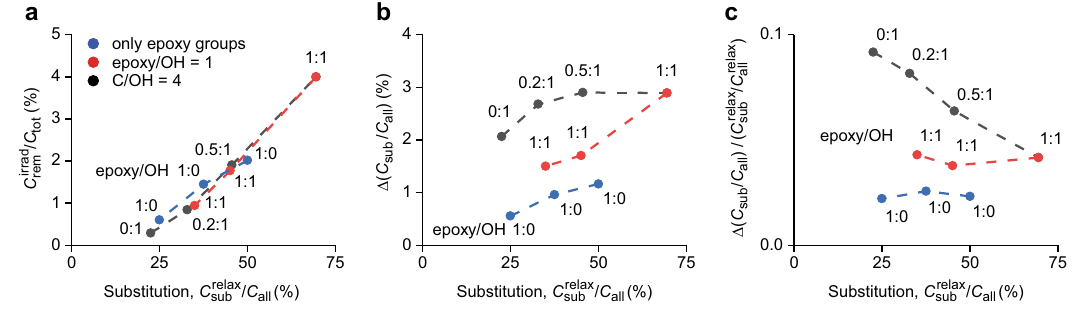
Fig. 6 | Ef fi ciencies of SHI-induced damage and defunctionalization of GO with different initial compositions. a Removal of C atoms from the lattice and b absolute and c relative changes in the substitution degree as functions of